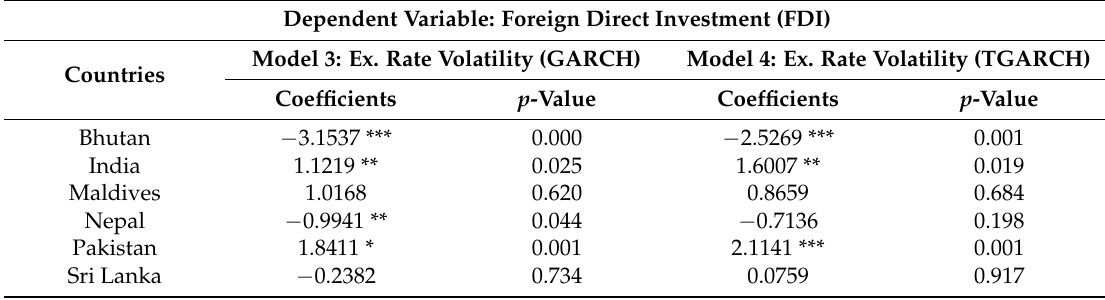
Table 8. FDI and Exchange Rate Volatility: Country-Wise